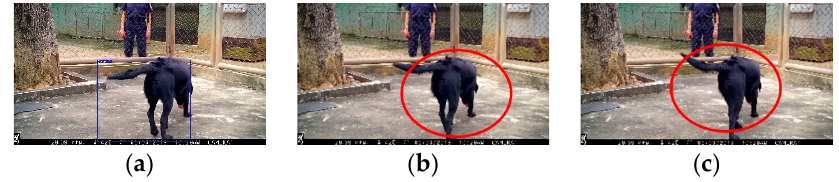
Figure 16. Dog not tracked in image 40 to 42. ( a ) Image 40; ( b ) Image 41; ( c ) Image 42.